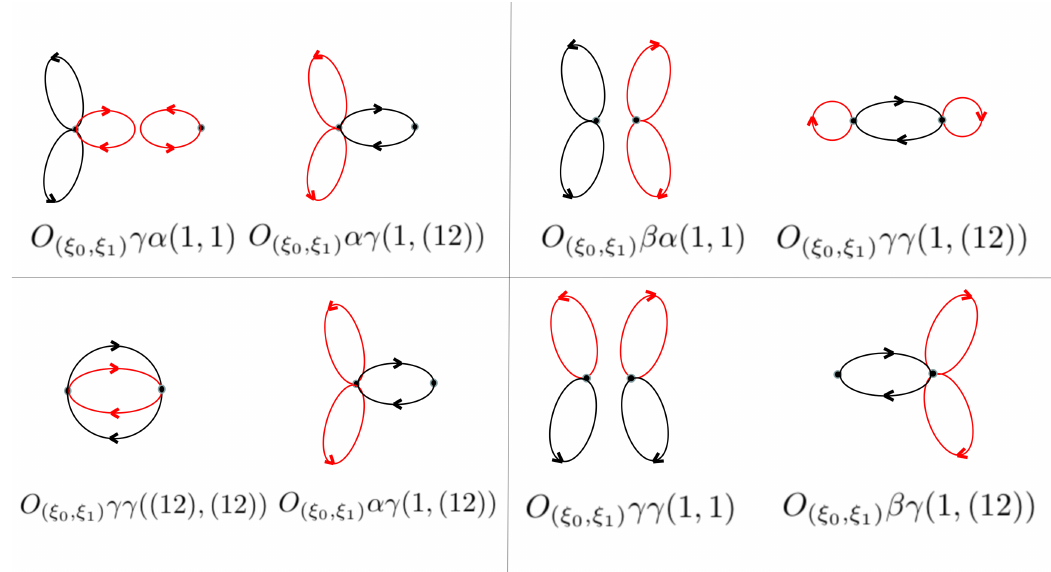
Figure 1 . Each pair of graphs shown are mixed by (5.50). They are not mixed by the leading contribution to the mixing involving φ 2 and φ 3 . The edges for φ 2 are colored red while edges for φ 3 are colored